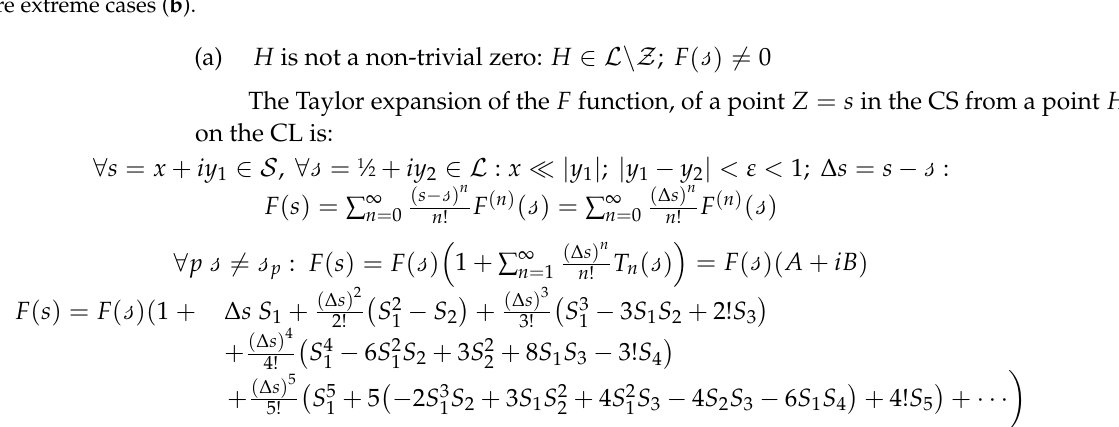
Figure 8. Images of circles of different radii after transformations by 𝜁 and 𝐹 . Input image in black, 𝜁 image in purple, 𝐹 image in green. Increasing the radius of the input image reduces the conformity of the projection, in both typical cases ( a ) and more extreme cases ( b ).